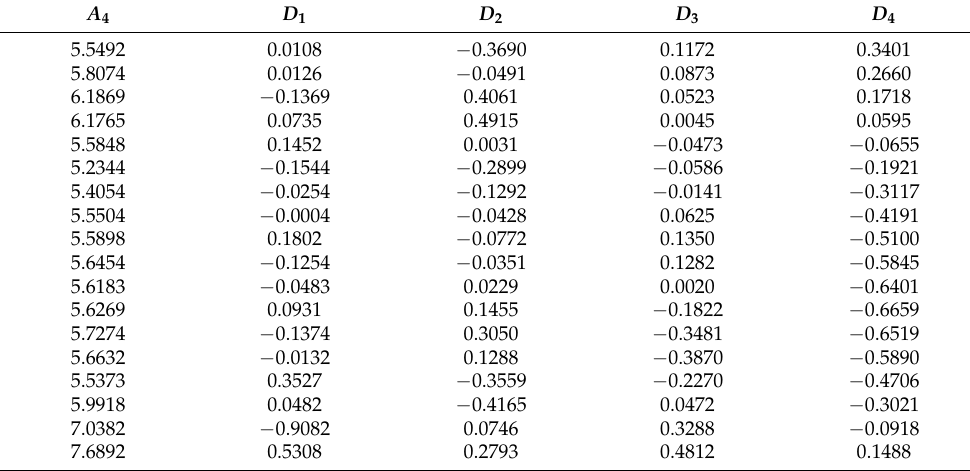
Table 5. Four-level wavelet decomposition of V 4